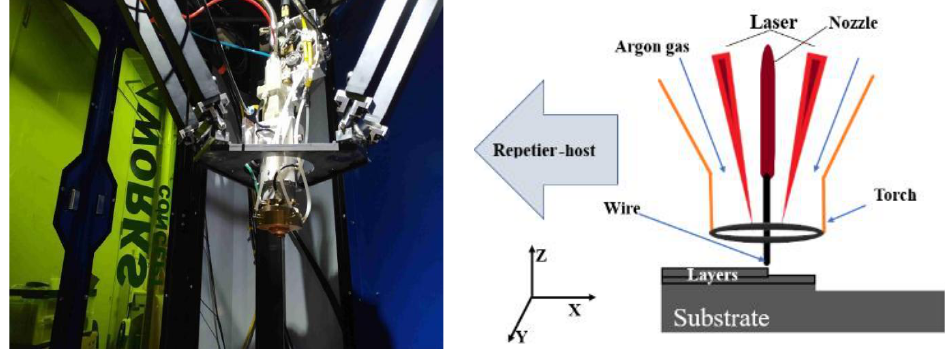
Figure 1. Coaxial printer setup and diagram.